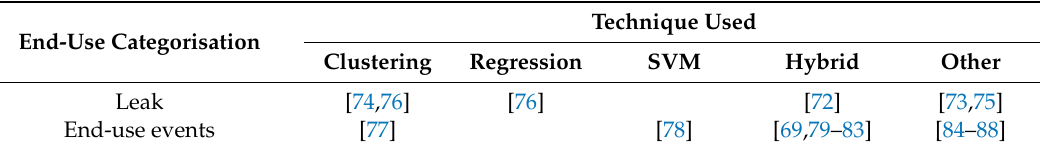
Table 4. Summary of the studies on water end-use